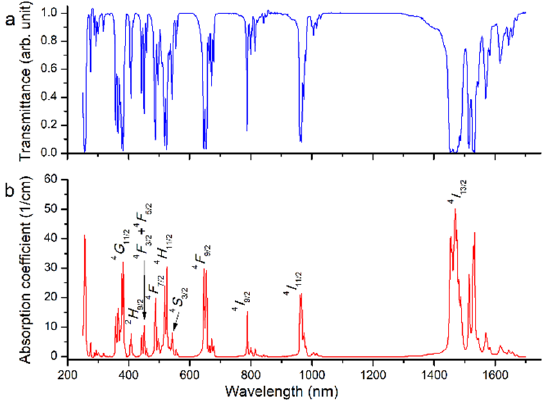
Figure 1. ( a ) Normalized transmittance spectrum and ( b ) absorption coefficient of the Er 3+ : YSAG ceramics (S 4 ).